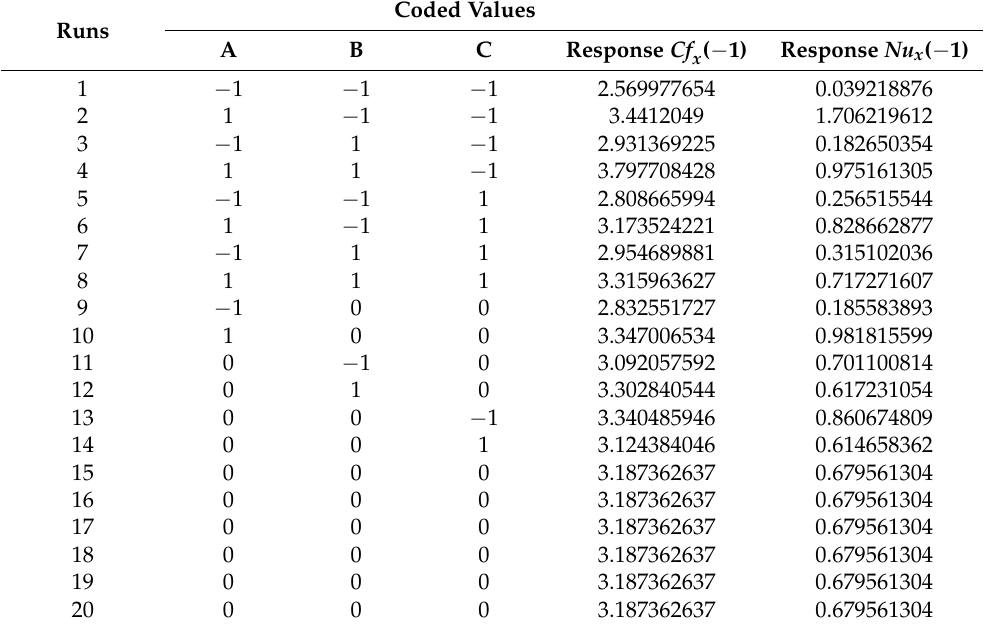
Table 4. Experimental design and